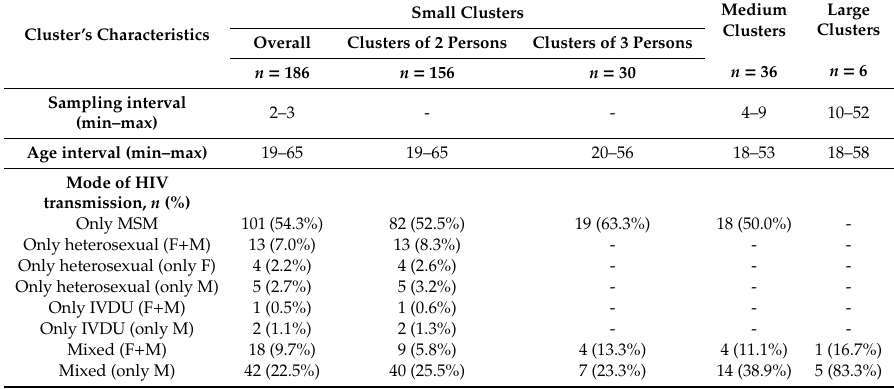
Table 2. Characteristics of molecular transmission clusters found among 3499 drug-naïve individuals living in